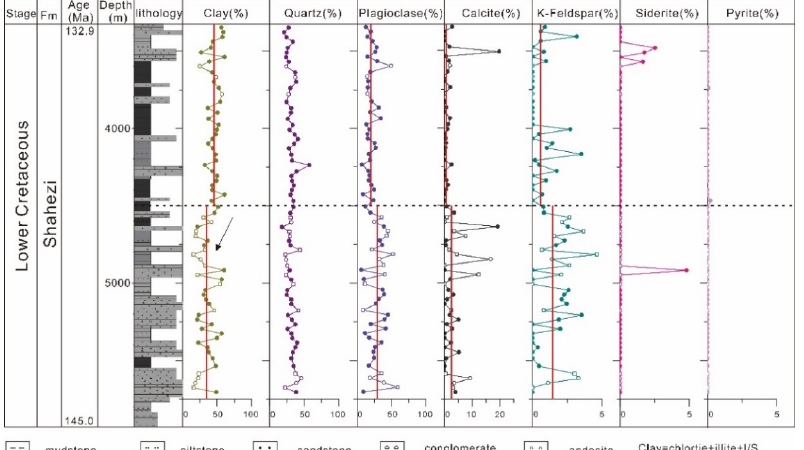
Figure 3. The whole-rock mineral content of the Shahezi Formation in SK-2. Solid circles are mudstone samples, hollow circles are sandstone samples, and hollow squares are siltstone samples.